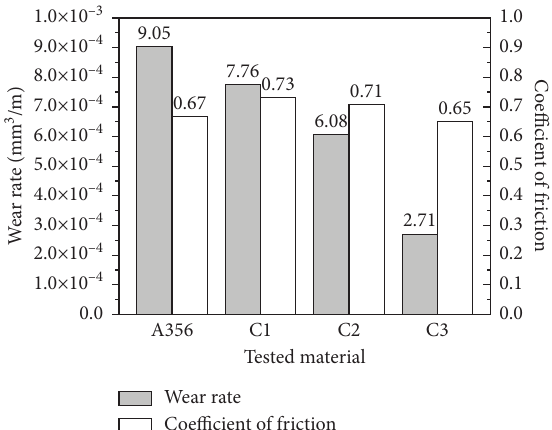
Figure 13: Wear rate and coefficient of friction values of heat treated (T6) A356 aluminum alloy, composite C1 (with 10 wt% Al 2 O 3 particles), composite C2 (with 10 wt% SiC particles), and hybrid composite C3 (with 10 wt% SiC and 1 wt% Gr particles); coefficient of friction values is for the steady state period—after 300m [73].